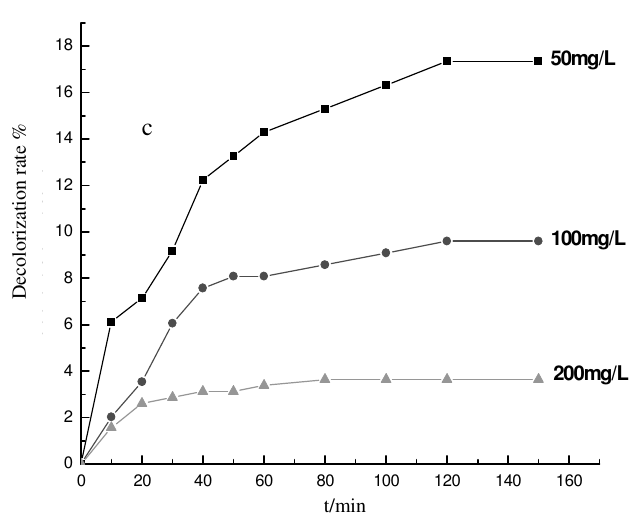
Figure 4. Influence of initial auramine lake yellow O concentration and temperature on decolorization rate ( ■ ) 50 mg/L, ( ● )100 mg/L, ( ▲ )200 mg/L (a) 5 °C, (b) 20 °C, (c) 35